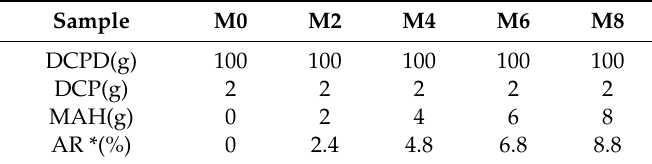
Table 1. The dosages of synthetic ingredients.